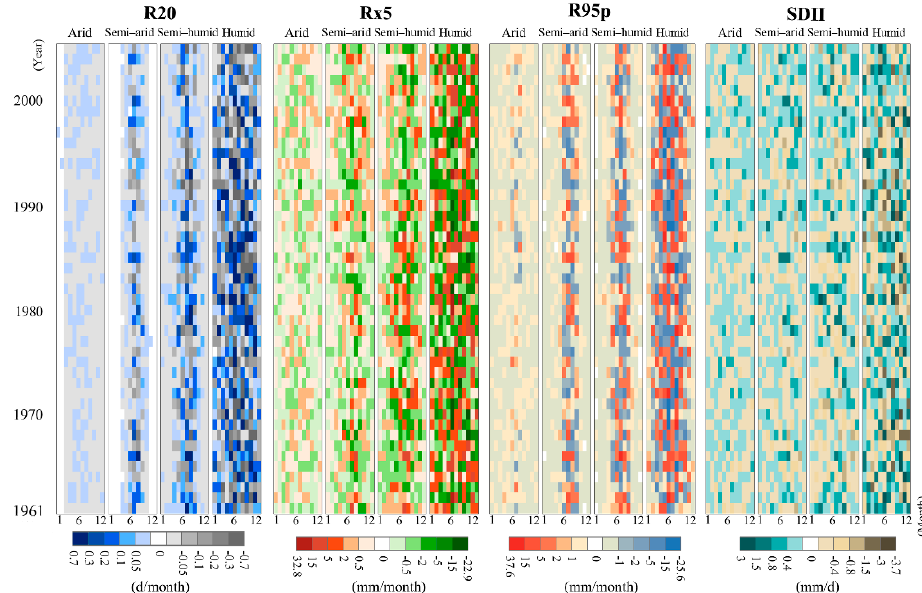
Figure 6. The temporal evolution trend of four precipitation index anomalies in 1961–2005. (R20: d/month; Rx5: mm/month; R95p: mm/month; SDII: mm/d).